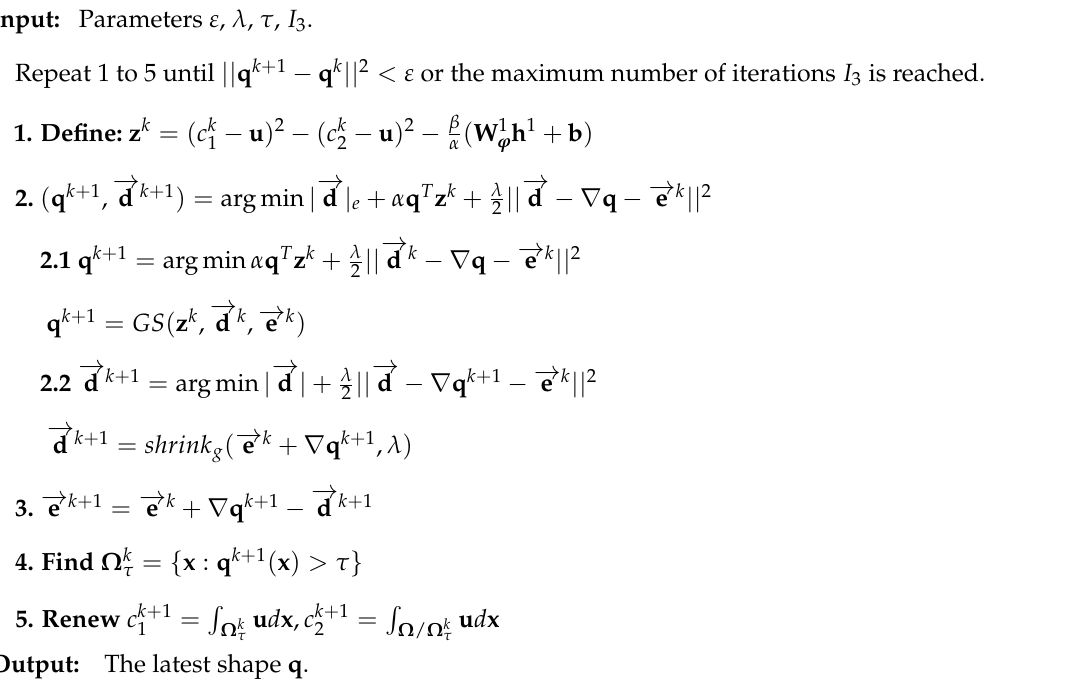
Algorithm 2 Detailed steps in Algorithm 1